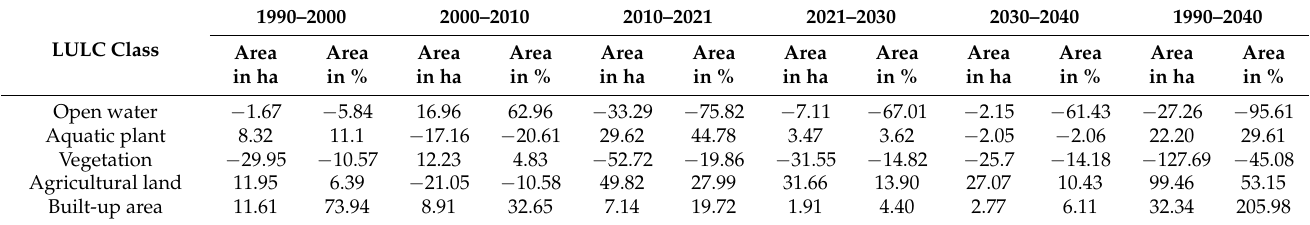
Table 6. Decadal changes of LULC in the study site between 1990 and 2040.